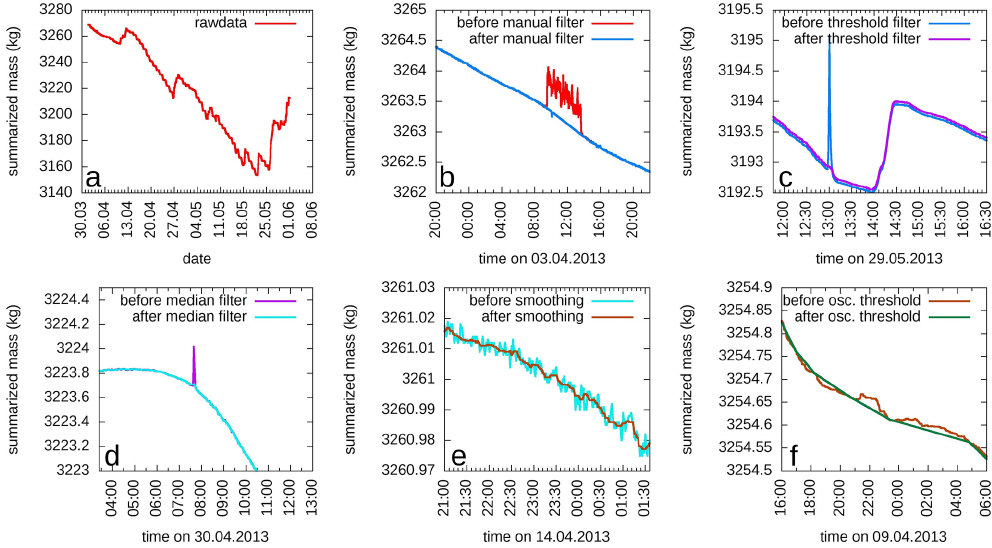
Figure 3. Examples for the effect of the different filtering steps on the mass data (here: summarized mass of lysimeter and seepage water tank of lysimeter BL1-L1). Please note the different scaling of the y axes. (a) raw data, (b) manual filter, (c) threshold filter, (d) median filter, (e) smoothing filter, (f) oscillation threshold